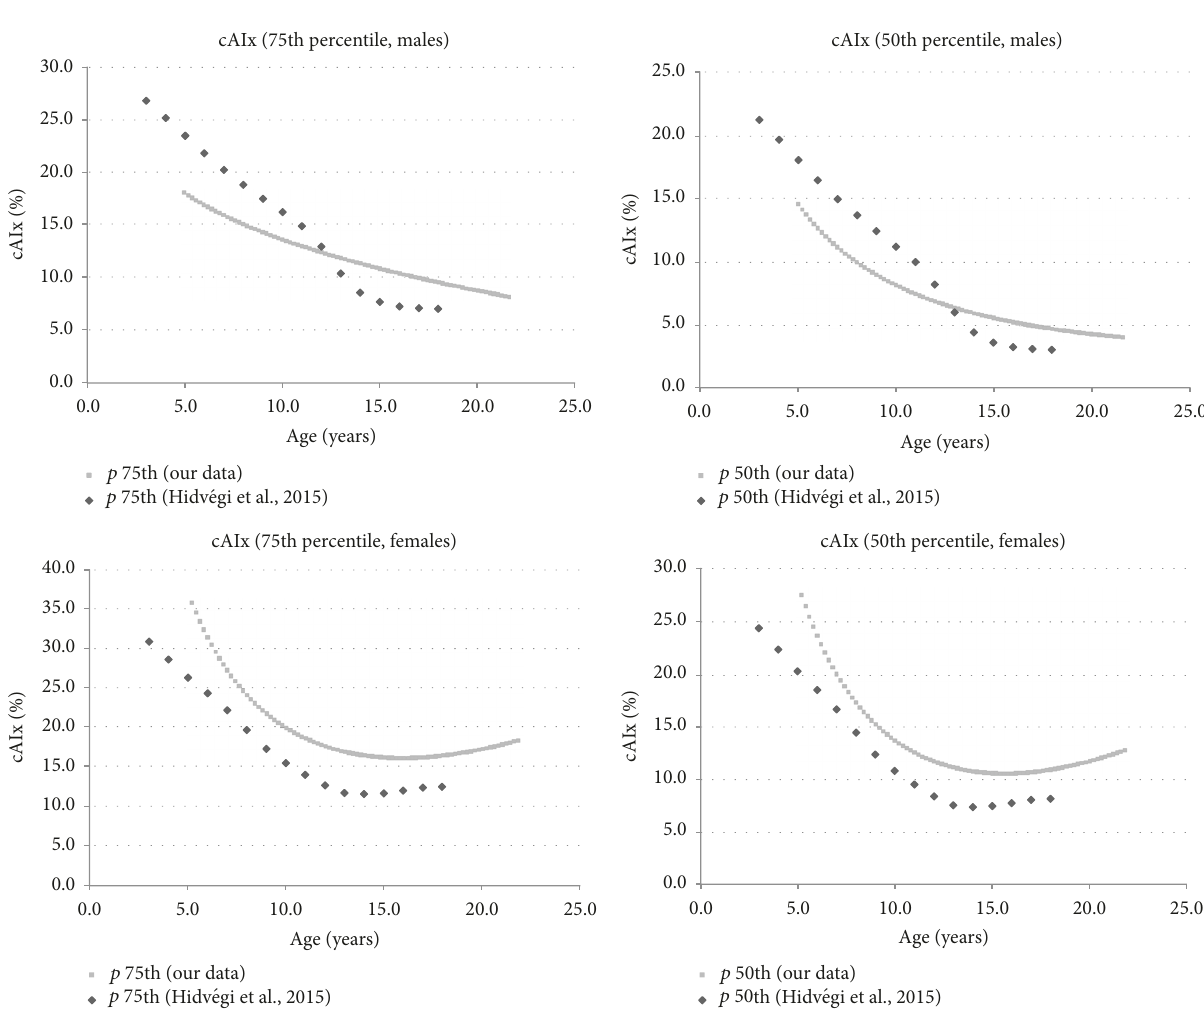
Table H: body height-related reference intervals (RIs) for central (aortic) augmentation index (cAIx) for females ( 𝑛 = 462 ). (Supplementary